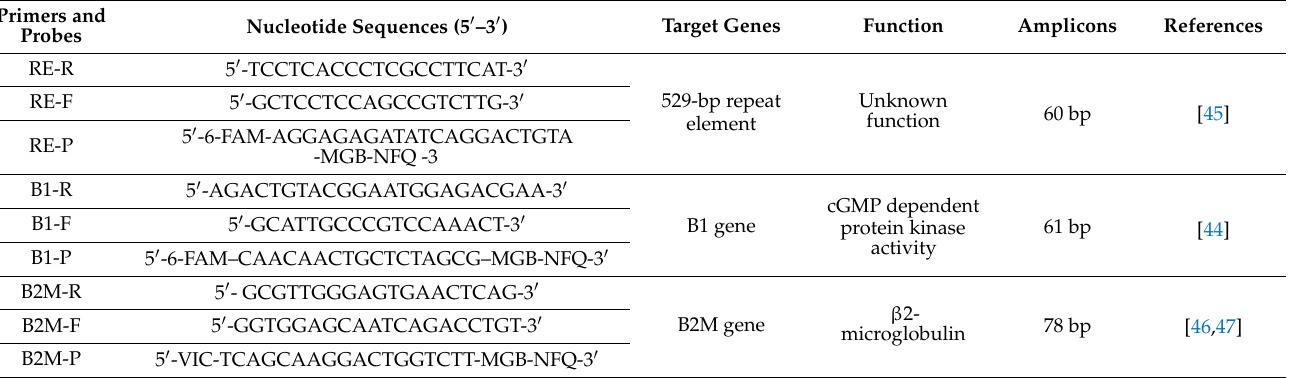
Table 2. The sequence of primers and